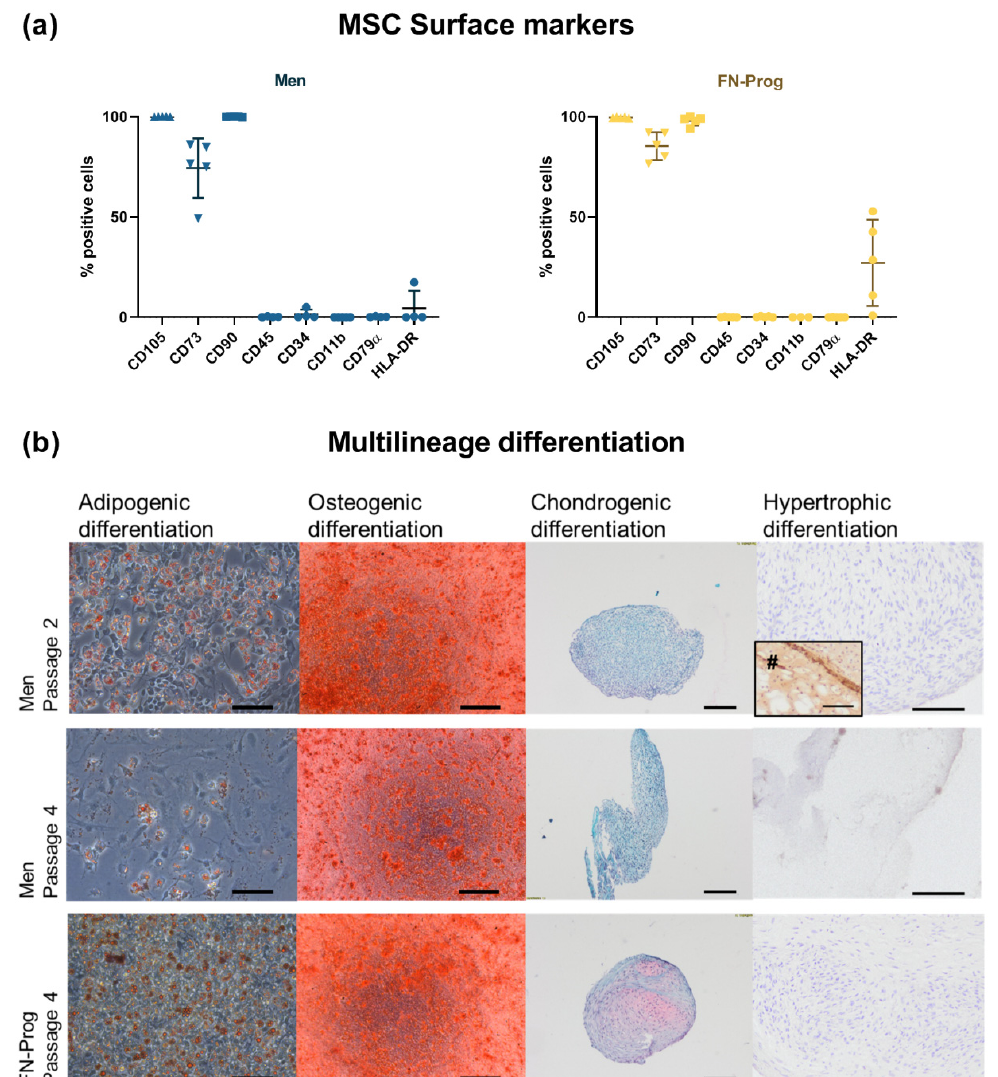
Figure 2. Characterization according to the MSC guidelines of the International Society for Cell & Gene Therapy [25] for ( a ) surface marker expression and ( b ) adipogenic (oil Red O staining), osteogenic (Alizarin Red staining), chondrogenic (Safranin-O/ Fast Green staining), hypertrophic (type X collagen immunohistochemistry) differentiation. n = 5 donors per group per condition. Donor-matched samples were used to culture the total meniscus population (Men) and fibronectin selected cells (FN-prog). #, bone marrow mesenchymal stromal cells passage 4 that were hypertrophically differentiated were used as positive control for type X collagen immunohistochemistry. Scale bars represent 100 µm.